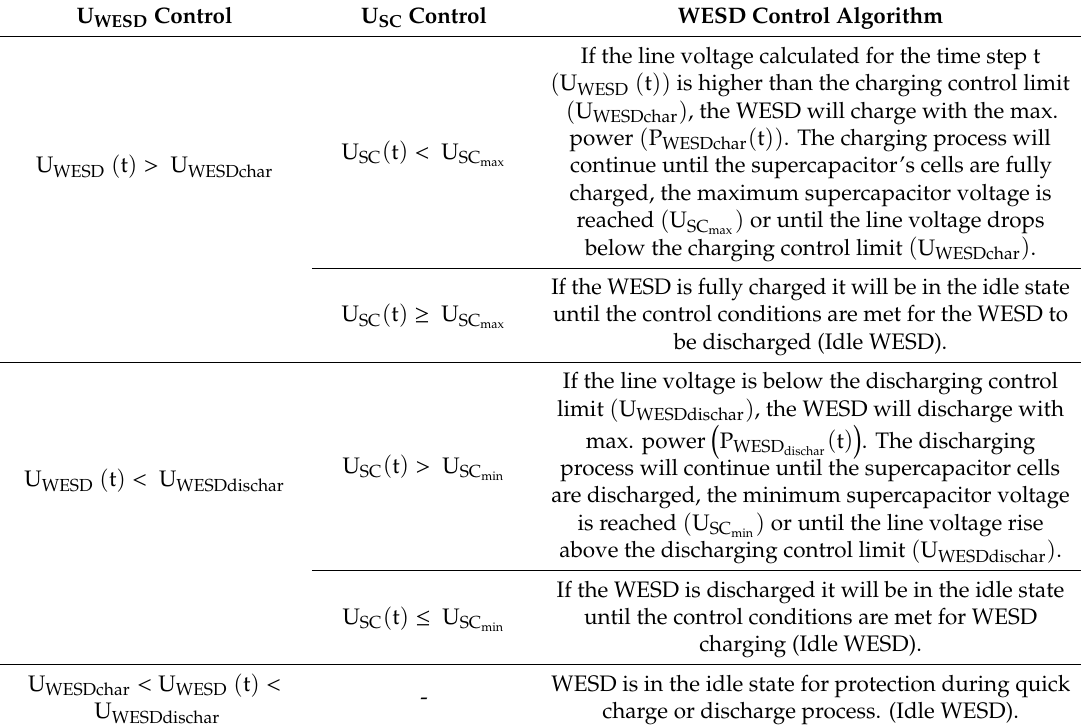
Table 1. WESD control